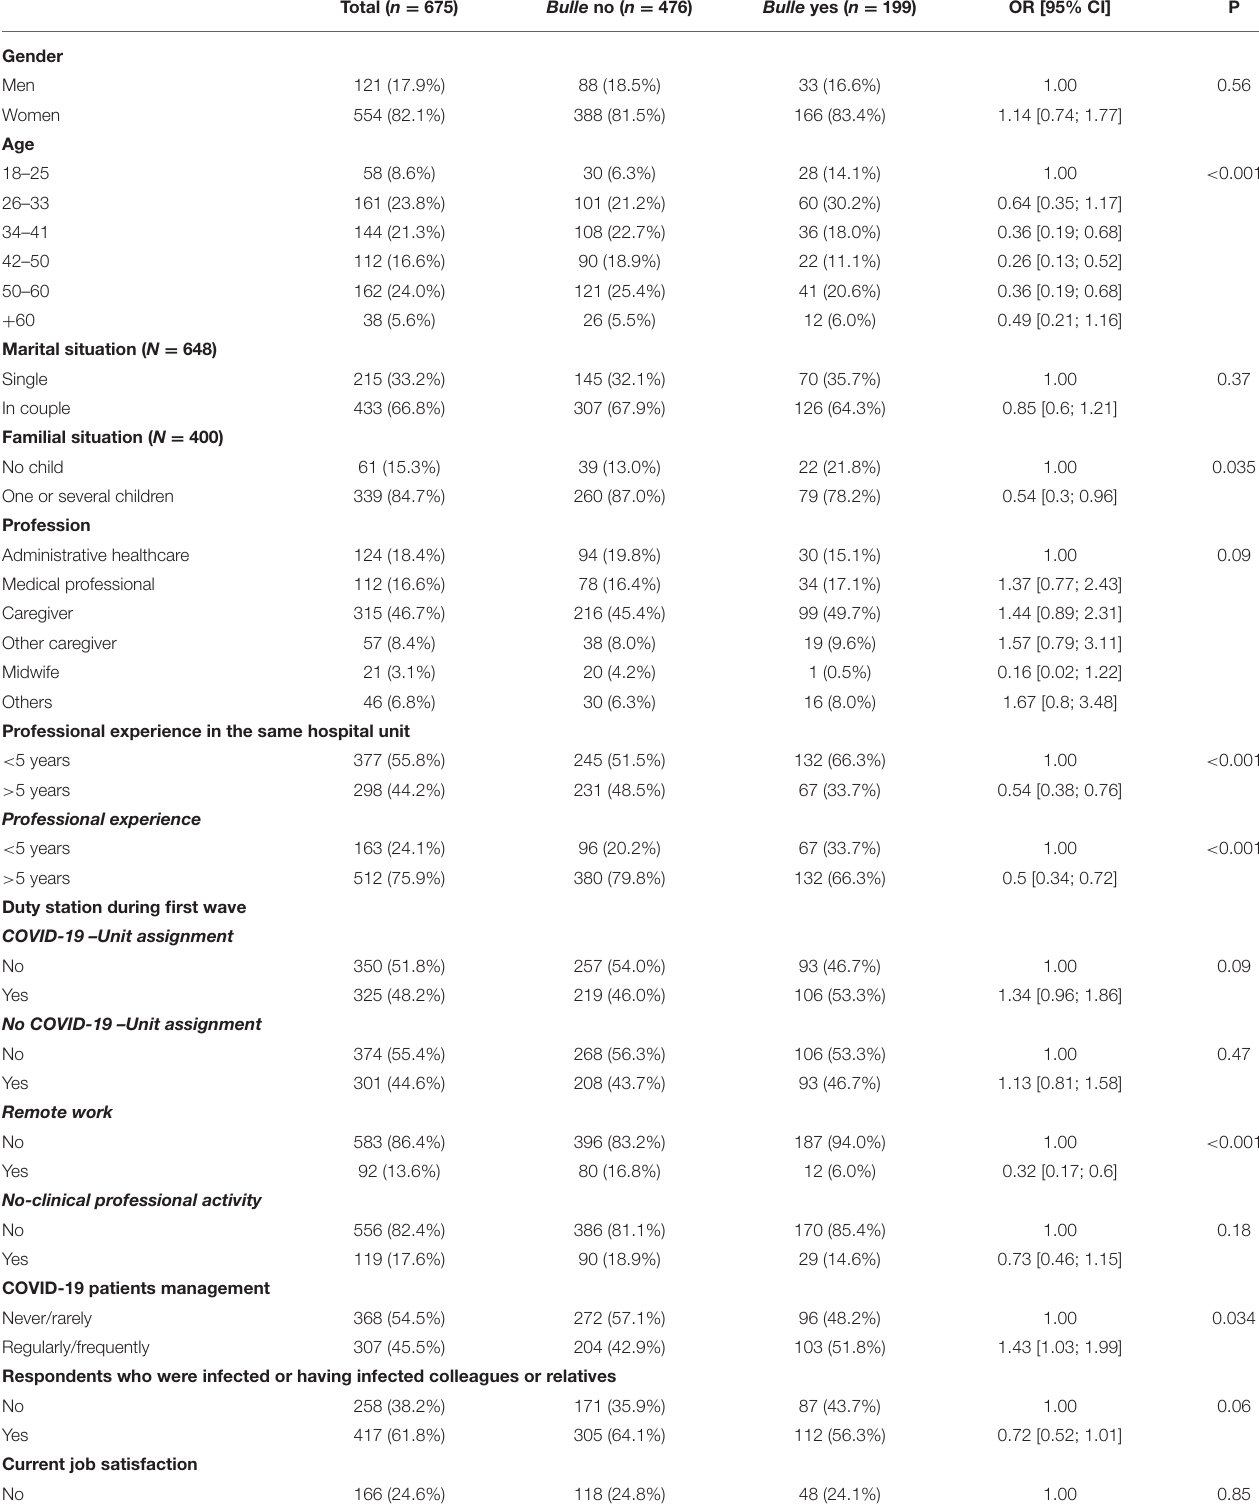
TABLE 1 | Sociodemographic and emotional characteristics related to COVID-19 and job satisfaction information according to access to the Bulle , among Paris Saint-Joseph Hospital